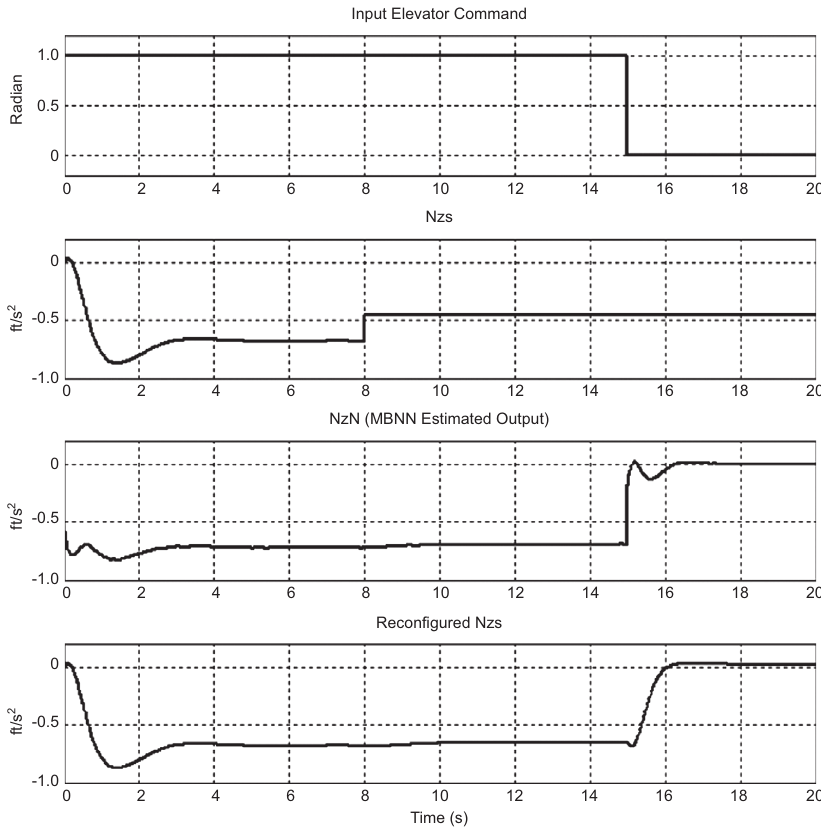
Figure 11. SFDA for Stuck Sensor Fault of “–0.45” at 8 s.